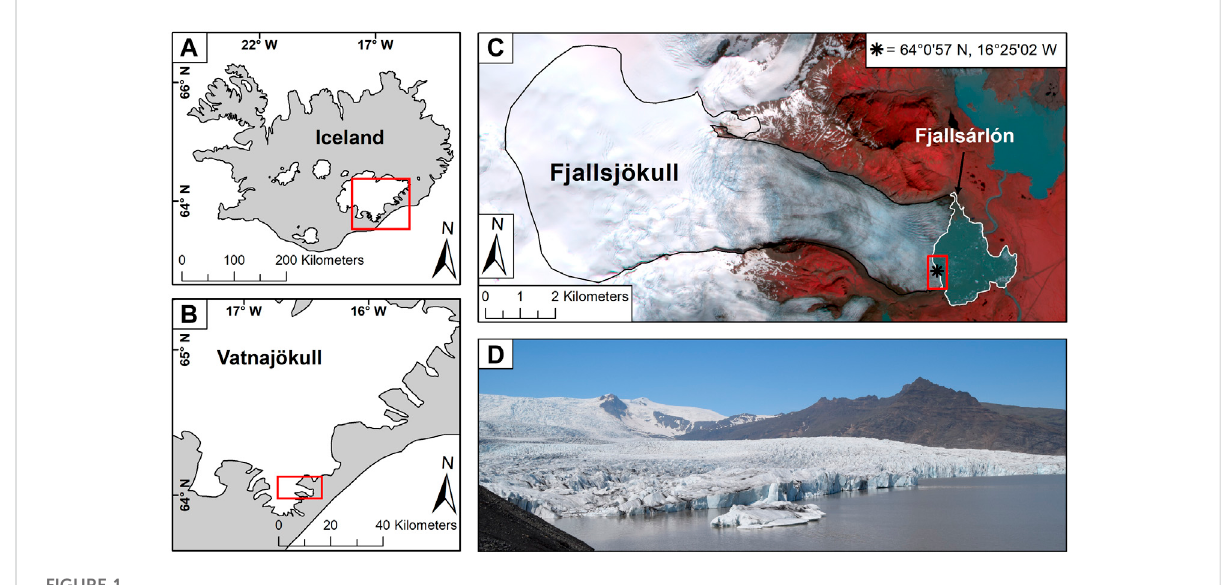
FIGURE 1 (A) Location of Fjallsjökull within Iceland, and (B) within the Vatnajökull Ice Cap. (C) Area of Fjallsjökull and Fjallsárlón as of July 2021. Red box delineates the areal coverage of the UAV surveys undertaken in this research. This is the same extent shown in Figure 2A. Background is a 4-band false-colour PlanetScope acquisition from 07/07/2021. (D) Field photograph of a portion of the calving front of Fjallsjökull, taken from the nearby lateral moraine on 15th July 2021. The calving front in the centre of the image is ~15 – 20 m high, and it is over this region that our UAV surveys